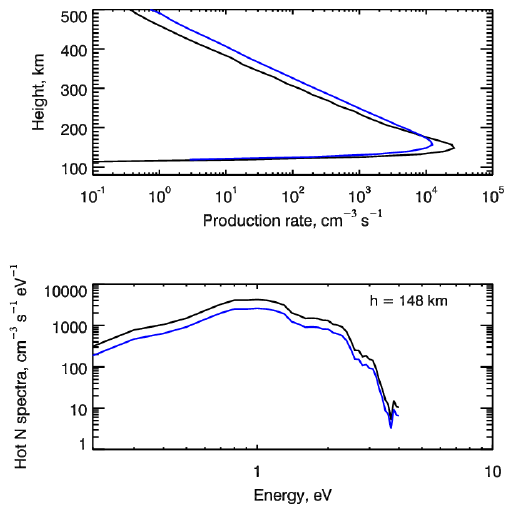
Figure 3. ( top panel ) Height profiles of the production rate of suprathermal nitrogen atoms formed in the electron impact dissociation of atmospheric N 2 molecules. ( bottom panel ) Calculated energy spectra of suprathermal N atoms formed at height of 148 km. Auroral electrons precipitate with energy E 0 = 1 keV and are characterized by monodirectional (black lines) and isotropic (blue lines) pitch-angle distributions at the upper boundary.